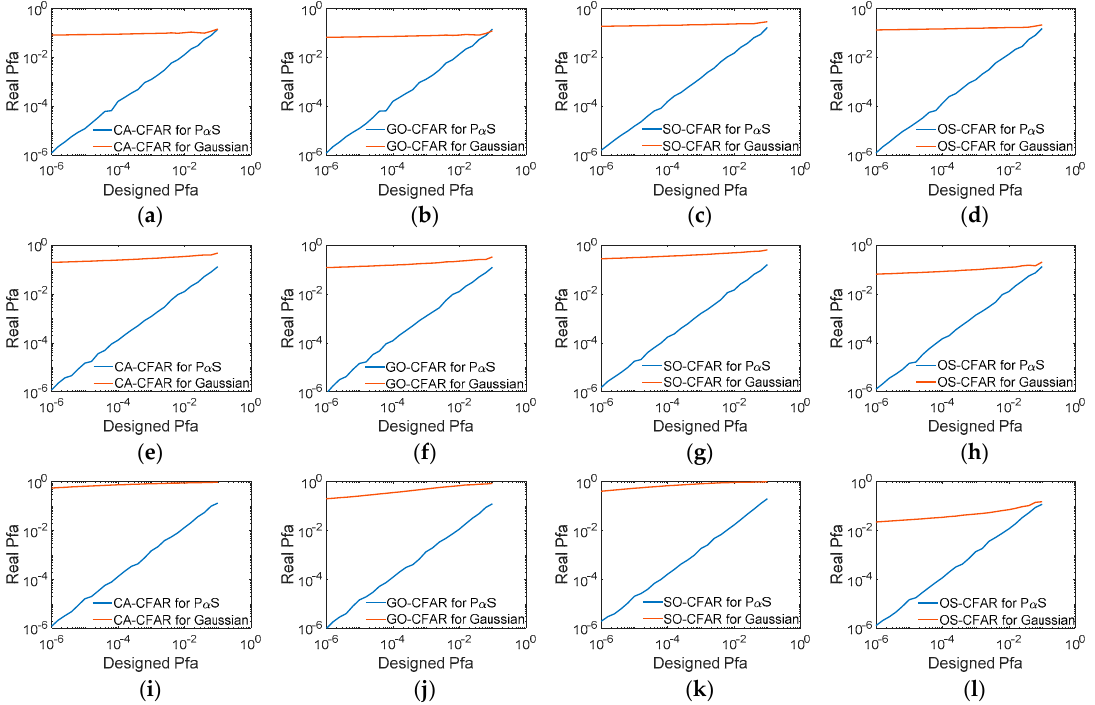
Figure 5. Real Pfas versus the designed Pfa in a nonhomogeneous P α S background. The parameters are N = 32, γ = 1, µ = 100 and R = 24. ( a ) CA, α = 0.2; ( b ) GO; ( c ) SO, α = 0.2; ( d ) OS ( k = 28), α = 0.2; ( e ) CA, α = 0.5; ( f ) GO, α = 0.5; ( g ) SO, α = 0.5; ( h ) OS ( k = 28), α = 0.5; (i) CA, α = 0.8; ( j ) GO, α = 0.8; ( k ) SO, α = 0.8; ( l ) OS ( k = 28), α =